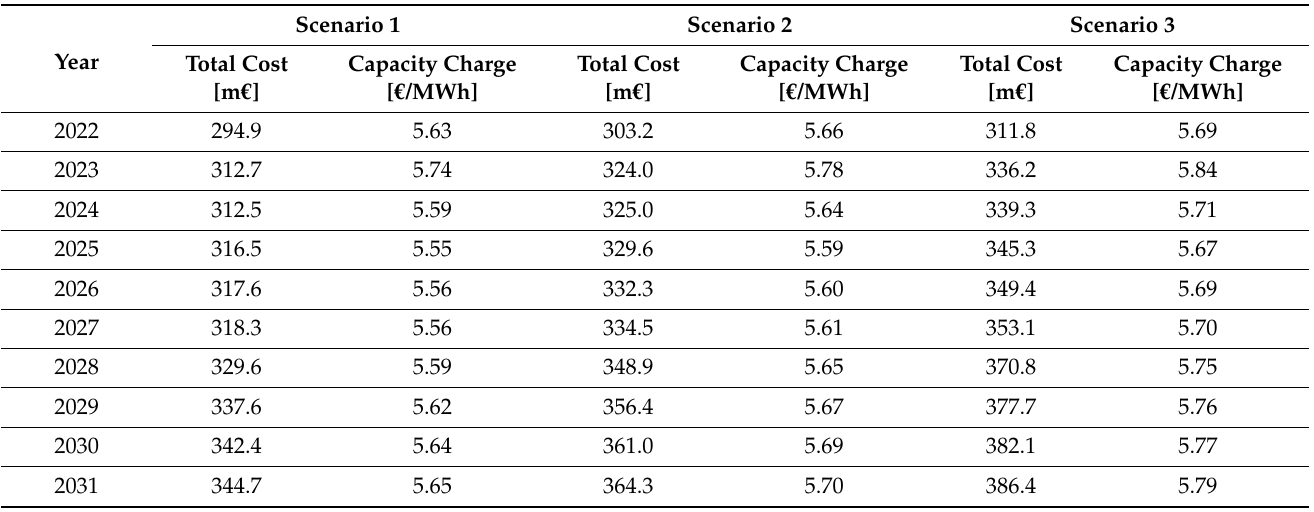
Table 4. CRM Cost–Base Strategy.